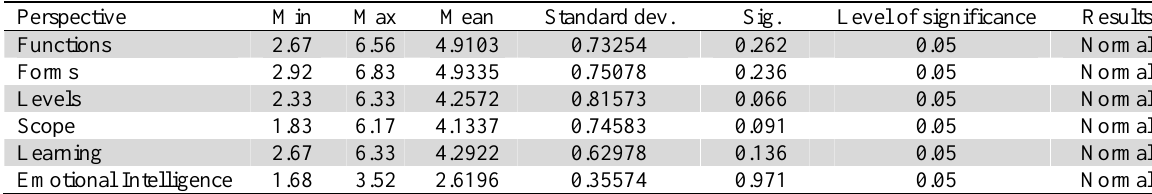
Fig. 3. Years of job